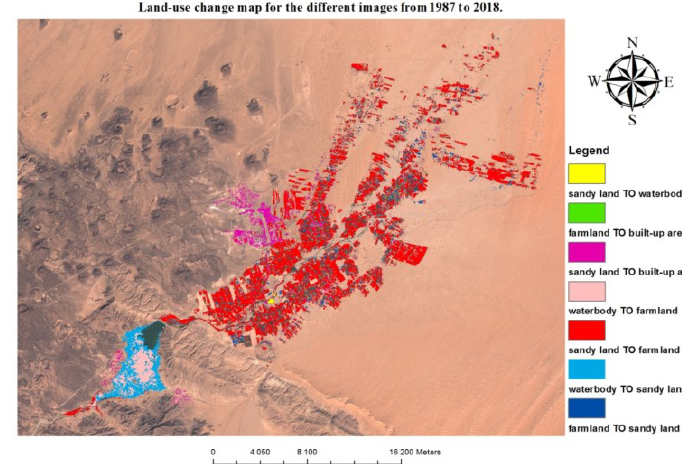
Fig.4. Geospatial distribution of LULC changes between 1987 and 2001.